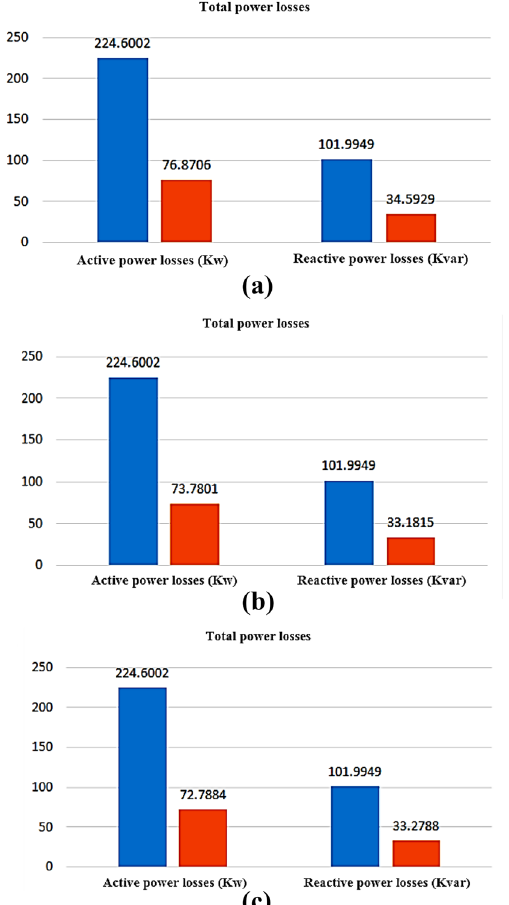
Fig. 11 The graph of total power losses in the 69-bus network, a unit resulting, b 0.85 Post-phase, c 0.85 pre-phase